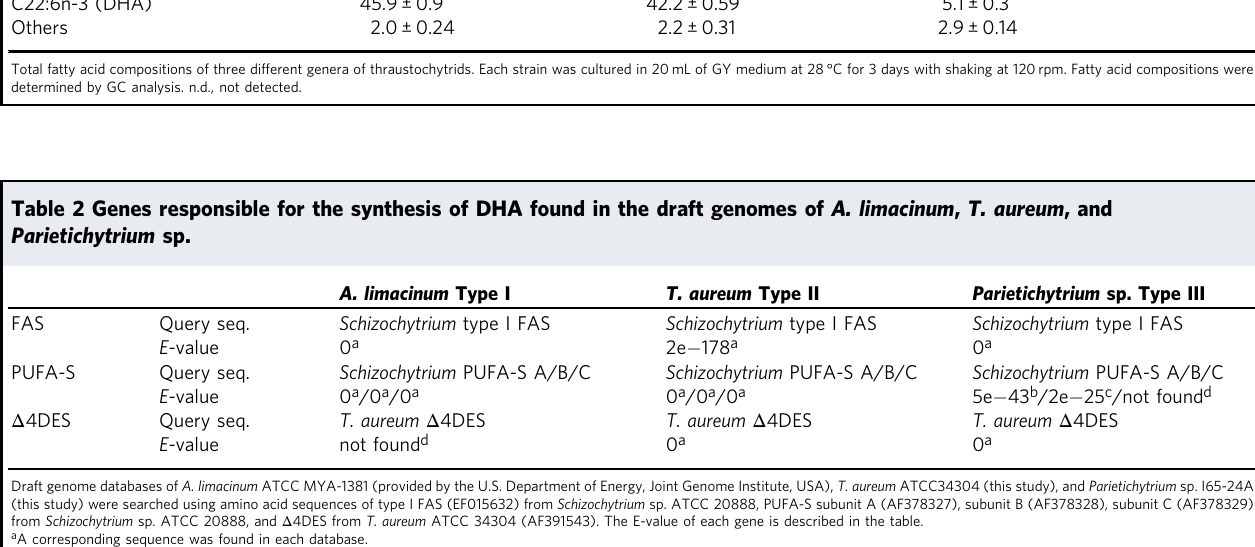
Fig. 1 Identi fi cation and classi fi cation of DHA synthesis systems of thraustochytrids. a Two pathways for the synthesis of n-6DPA and DHA in thraustochytrids. One occurs via PUFA-S, directly synthesizing n-6DPA or DHA from acetyl-CoA and malonyl-CoA in a polyketide synthase-like manner. The other is the ELO/DES pathway, in which PA is converted to DHA through six desaturation and three elongation steps. b LC-PUFA compositions of three different genera of thraustochytrids ( A. limacinum, T. aureum , and Parietichytrium sp.SEK358). Each strain was cultured in 20 mL of GY medium at 28 °C for 3 days with shaking at 120 rpm. LC-PUFAs were determined by GC. c LC-PUFA pro fi les of WT and Δ 4DES KO of Parietichytrium sp. SEK358. The data shown are the mean ± SD. ( n = 3). The n values are numbers of replicates. d Generation of 13 C 18 -labeled 22:6 (DHA) and its intermediates from the precursor 13 C 18 -C18:1 in Parietichytrium sp. Cells of Parietichytrium sp. SEK358 were incubated at 25 °C with 0.25 m Μ 13 C 18 -C18:1 for 24 h. The 13 C 18 -labeled fatty acids were obtained from total lipid fractions after alkaline treatment and were determined by MRM analysis using LC-ESI MS/MS, as shown in Supplementary data set 1. Peak intensities of 13 C 18 -labeled fatty acids were normalized to an internal standard (C12:0) (normalized intensity). The data shown are the mean ± SD. ( n = 3). The n values are numbers of replicates. e Time course of the generation of 13 C 18 -C22:6 generated from 13 C 18 -C18:1 in Parietichytrium sp., A. limacinum , T. aureum WT, and T. aureum PUFA-S KO. Cells were incubated with 0.25 m Μ 13 C 18 -C18:1 and collected at the indicated